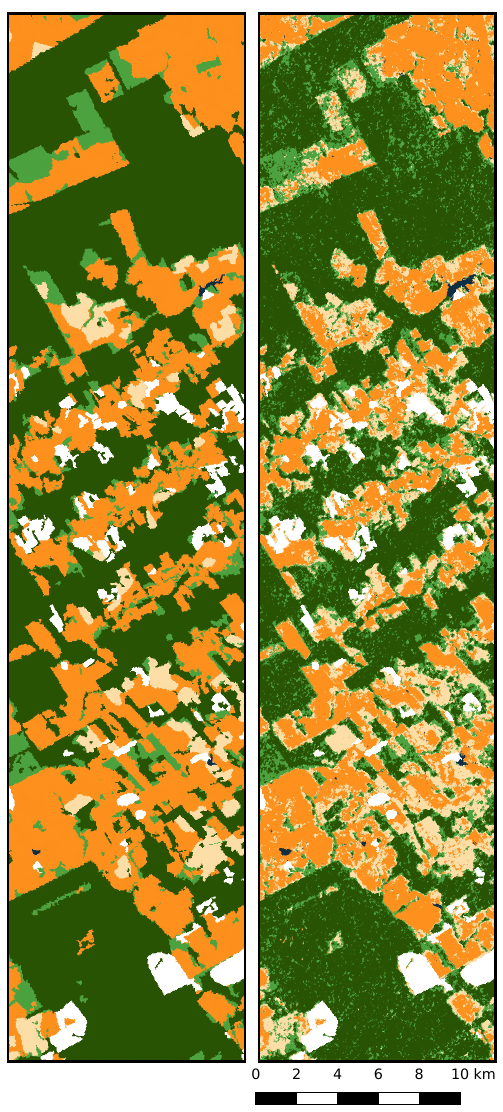
Figure 6. Final classification product using multi-temporal, multi-frequency imagery compared to TerraClass reference data set. Note that inconsistent classes from the TerraClass dataset are masked out white. Table 3. Population error matrix derived from classification of the full dataset and TerraClass reference data. Numbers reflect area adjusted percentages as introduced by Equation